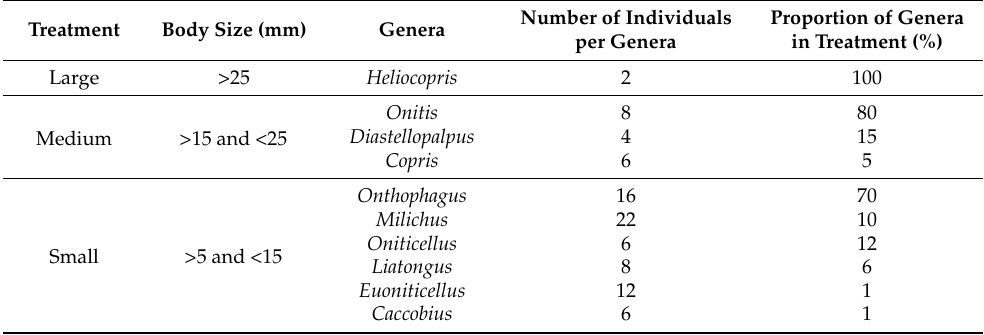
Table 1. Treatment, body size, and ordered proportionate composition of genera used in each replicate.